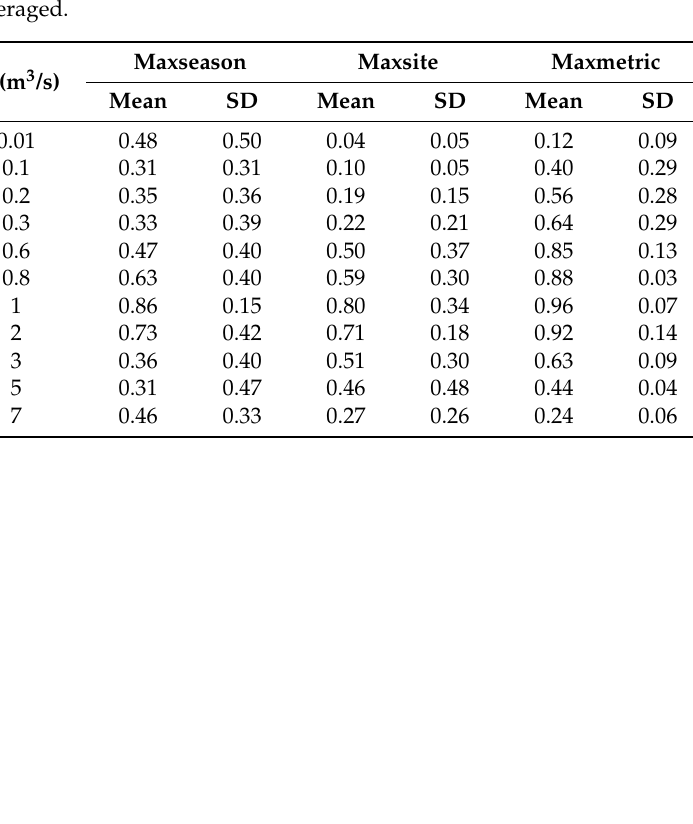
Table A2. Seasonal OFS means and standard deviations (SD) within the various κ -normalization alternatives for the Parapeiros reach. The OFS values of spring, summer and autumn for each discharge (Q) have been